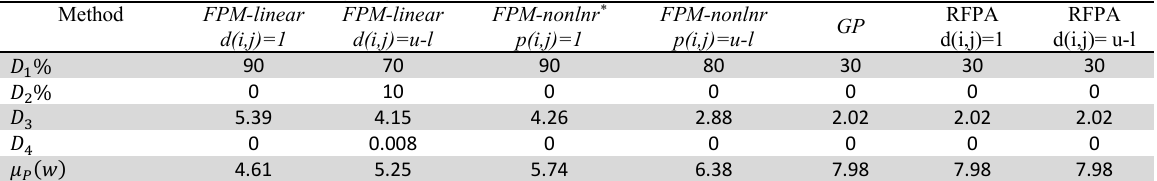
Five-dimensional inconsistent judgments